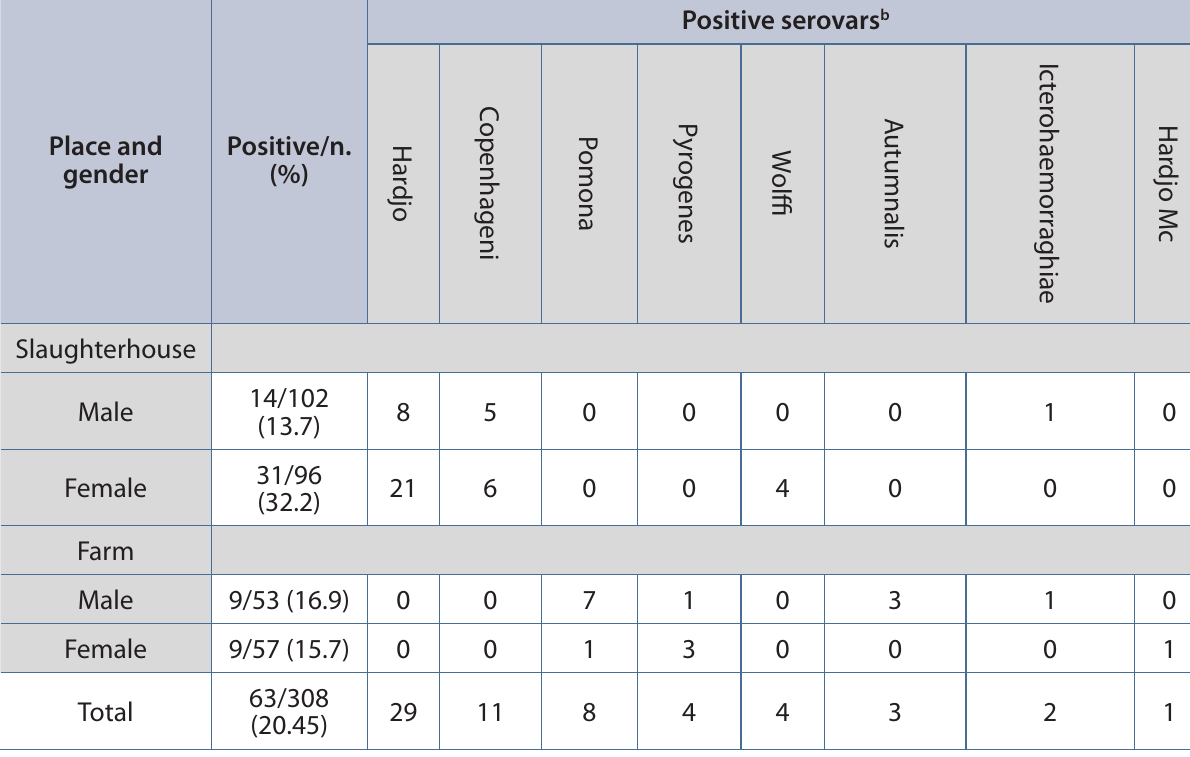
Place and gender